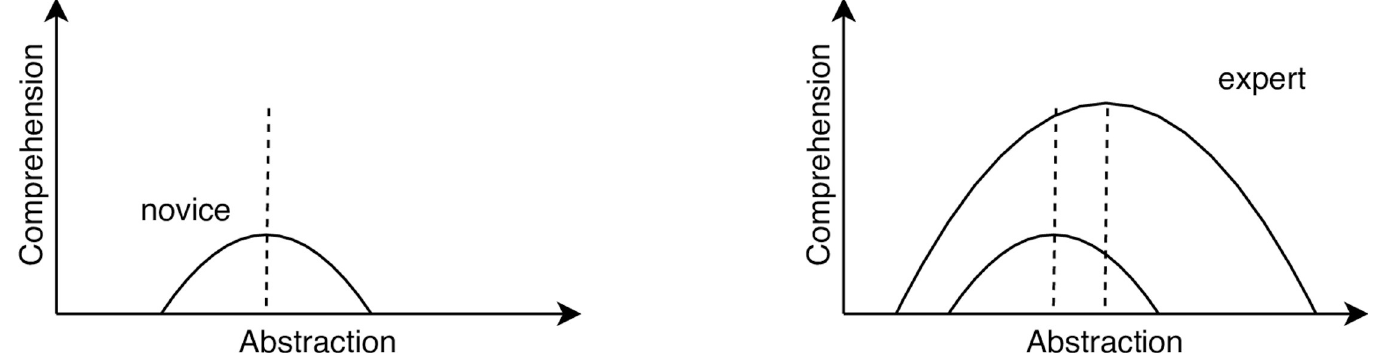
Fig 1. Comprehension curves for novices and